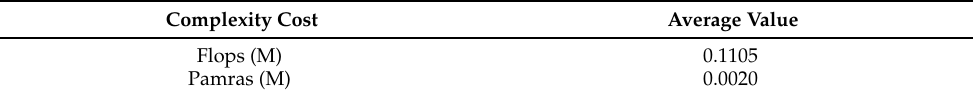
Table 8. The average value of related complexity of the generated model.